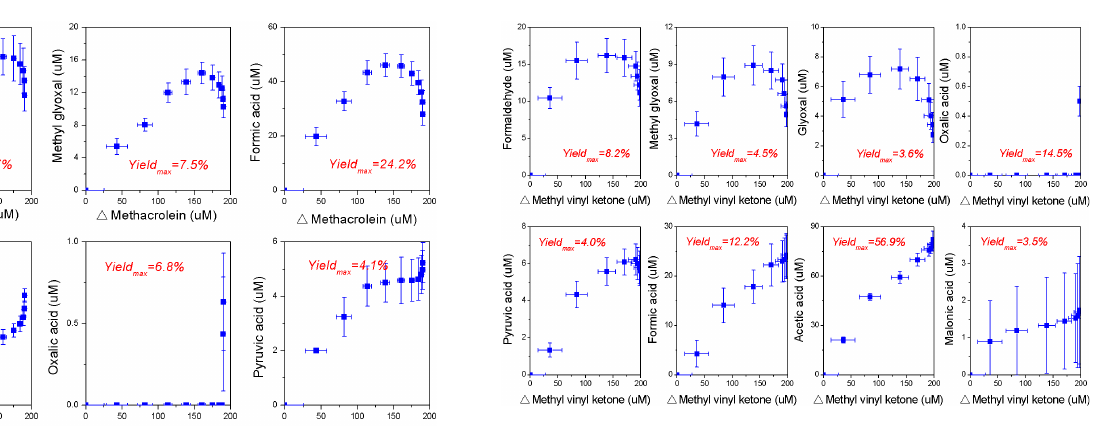
Fig. 7. Yields of low-molecular-weight products from the OH- oxidation of MVK.